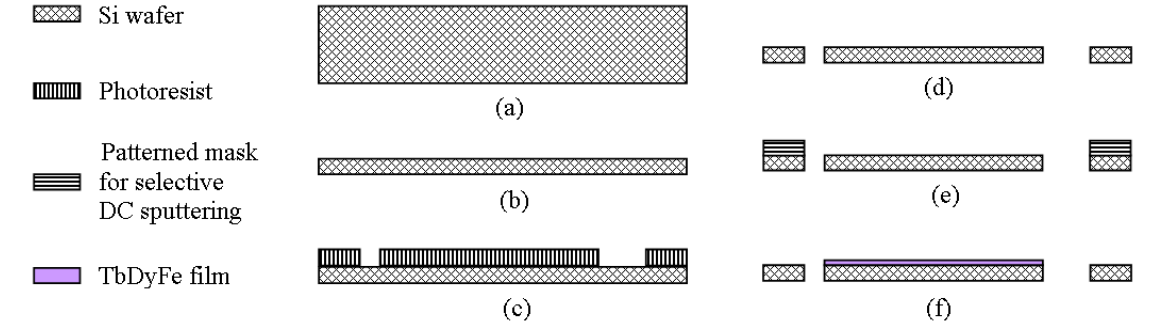
Figure 2. Micromachining and TbDyFe thin film